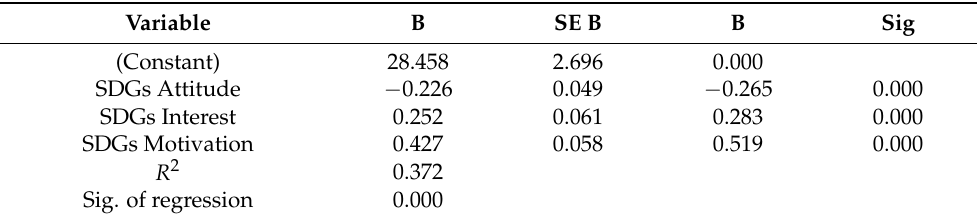
Table 14. Summary of regression analysis for SDGs attitude, interest, and motivation predicting